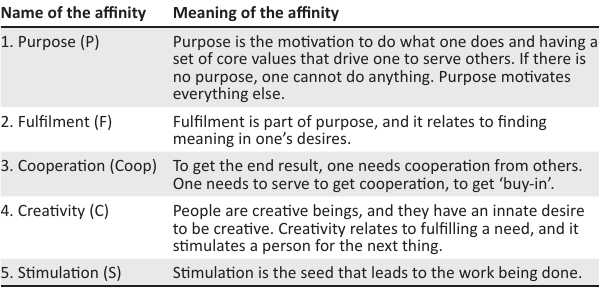
TABLE 1: Affinities generated by the focus group.